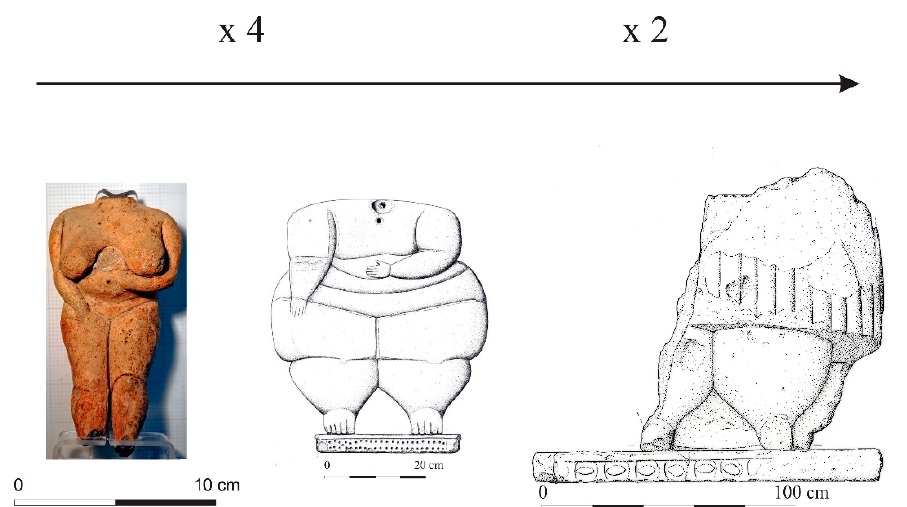
Figure 5. Scales of figurative sculpture.